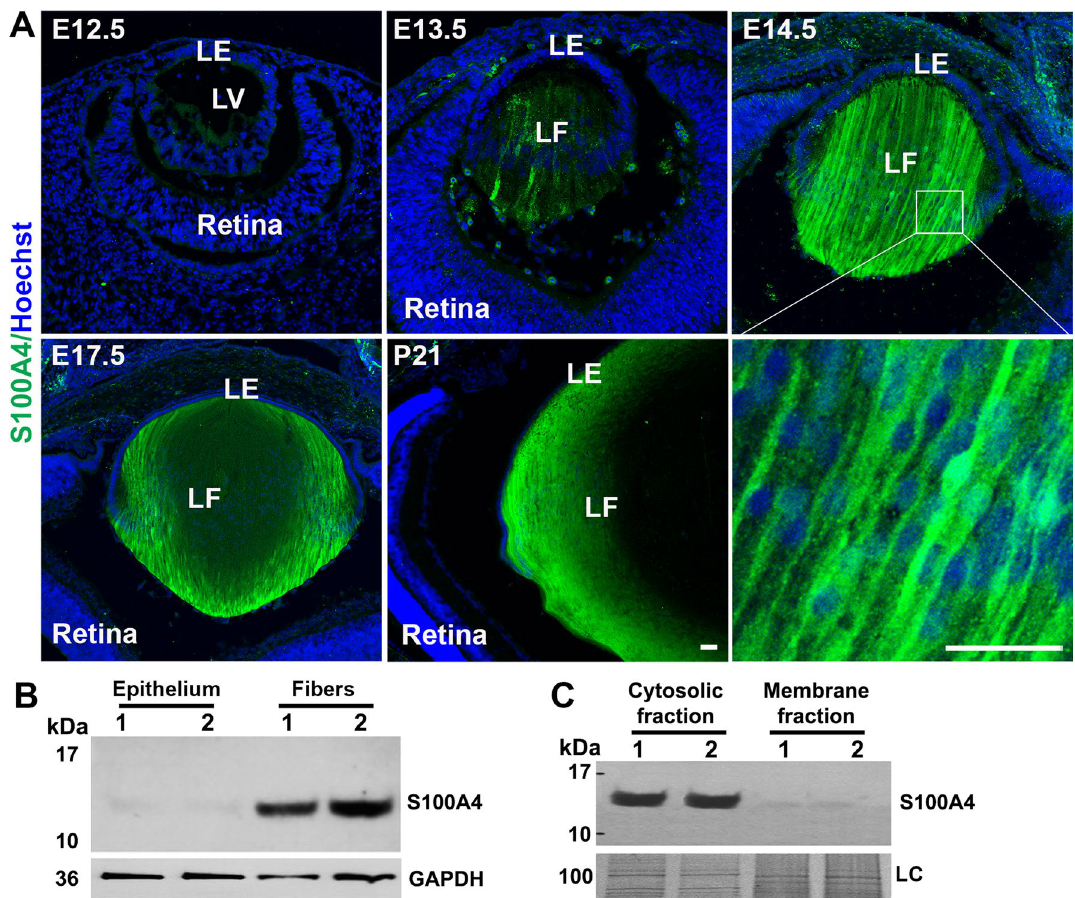
Figure 1. Expression and distribution of S100A4 in differentiating and mature fibers of the mouse lens. ( A ) Immunofluorescent staining of S100A4 distribution (green) in sagittal sections of embryonic (E12.5, 13.5, 14.5 and 17.5) and differentiated (P21) mouse lenses. Nuclei are stained with Hoechst (blue). There seems to be no nuclear localization of S100A4 in lens fibers as shown in the bottom right panel (magnified image of the indicated area of E14.5 lens). LE lens epithelium, LV lens vesicle, LF lens fibers. Scale bars 20 μm. Representative images of one of three independent specimens analyzed are shown. ( B ) Immunoblot analysis of S100A4 in P21 mouse lens epithelium and fiber mass reveals its distribution specifically in fibers. ( C ) Immunoblot of S100A4 in P21 mouse lens lysates show its distribution primarily to the soluble (100,000 g supernatant) fractions compared to membrane fractions (100,000 g pellet). For soluble and membrane fractions, protein samples from the respective fractions separated on SDS-PAGE were stained with Gelcode blue with the staining intensity of the indicated protein band used as a loading control (LC). GAPDH was used as a loading control ( B ). Lanes 1 and 2 represent two biological replicates ( B , C